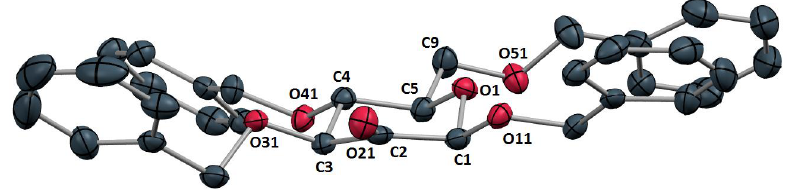
Figure 1. Molecular structure of 2 . Hydrogen atoms as well as a disorder involving the O 51 benzyl group are omitted for clarity. Ellipsoids are drawn at a 50% probability level. Red = oxygen, gray = carbon.